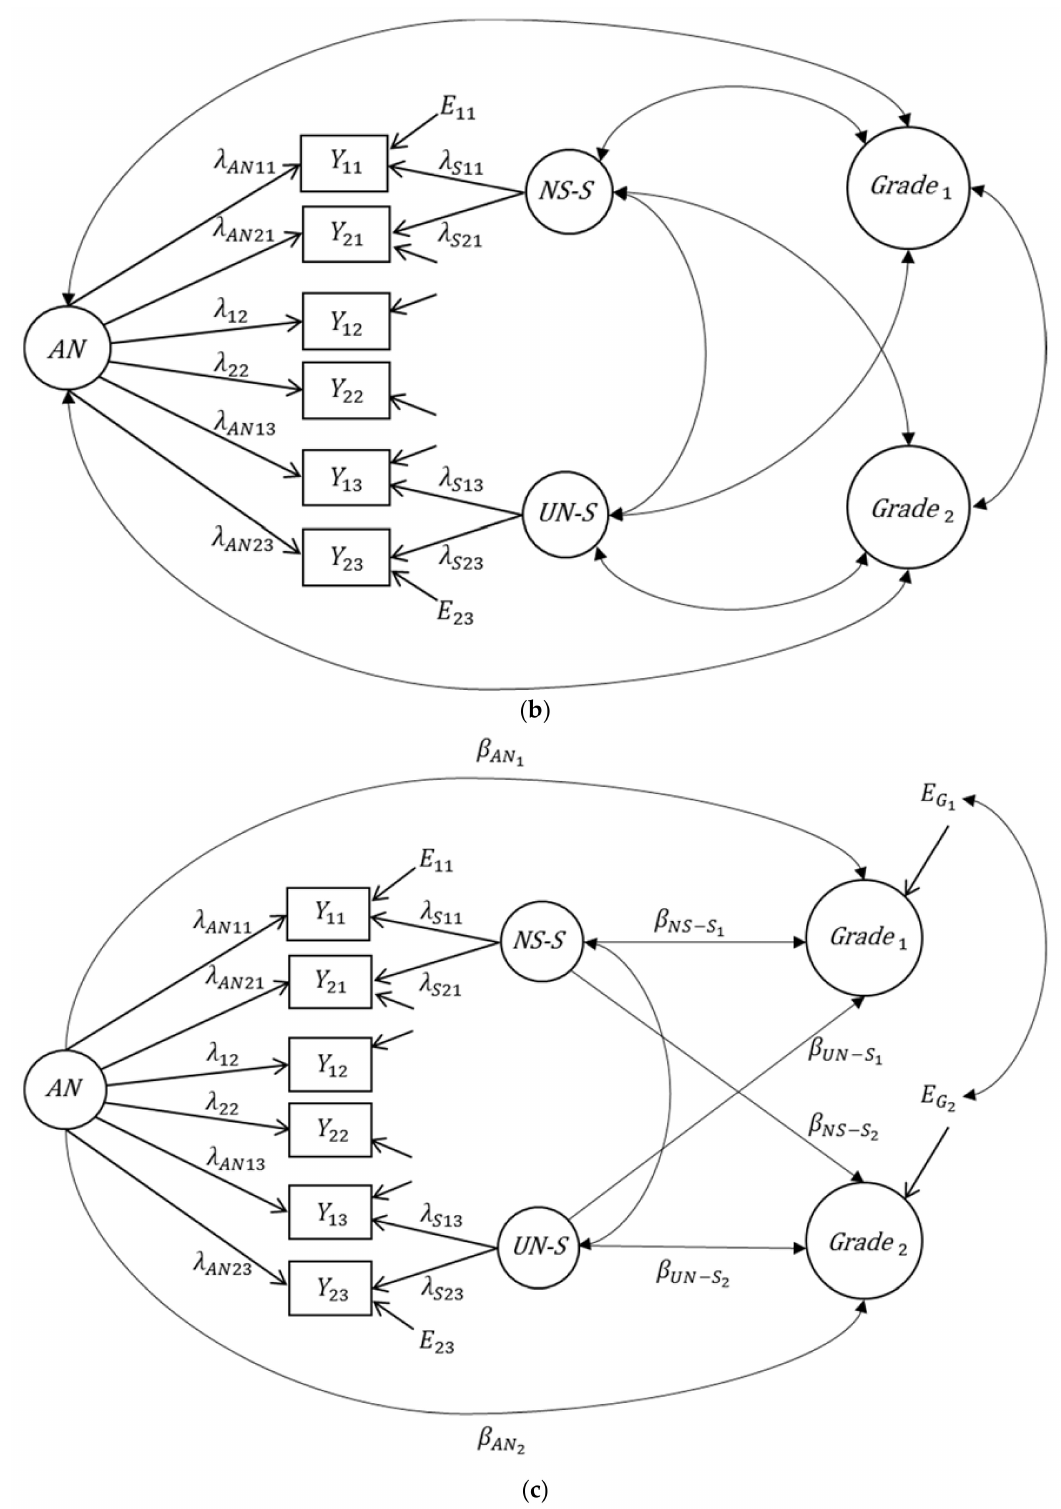
Figure 3. Bifactor( S -1) model and its extensions to criterion variables. ( a ) Bifactor( S -1) model without criterion variables, ( b ) bifactor( S -1) model with correlating criterion variables (grades), and ( c ) multiple latent regression bifactor( S -1) model. The factors of the extended models depicted refer to the empirical application. G : general factor, S k : specific factors; NS-S : specific factor number series, AN-S : specific factor verbal analogies, UN-S : specific factor unfolding. E ik : measurement error variables, E G1 / E G2 : residuals, λ : loading parameters, β : regression coefficients, i : indicator, k :